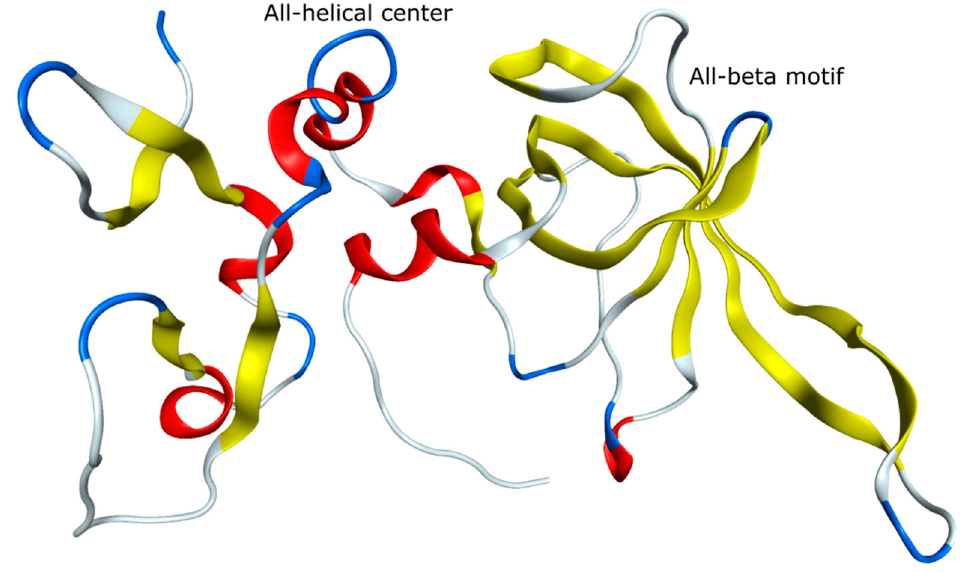
Figure 6. Structure of TIMP-2 (PDB 1BR9) [93] .